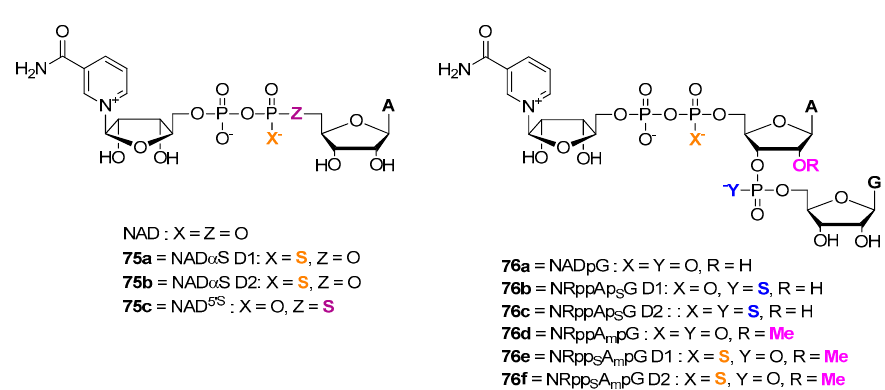
Figure 20. Hydrolysis-resistant NAD + analogs designed to study the corresponding NAD-RNAs [96].